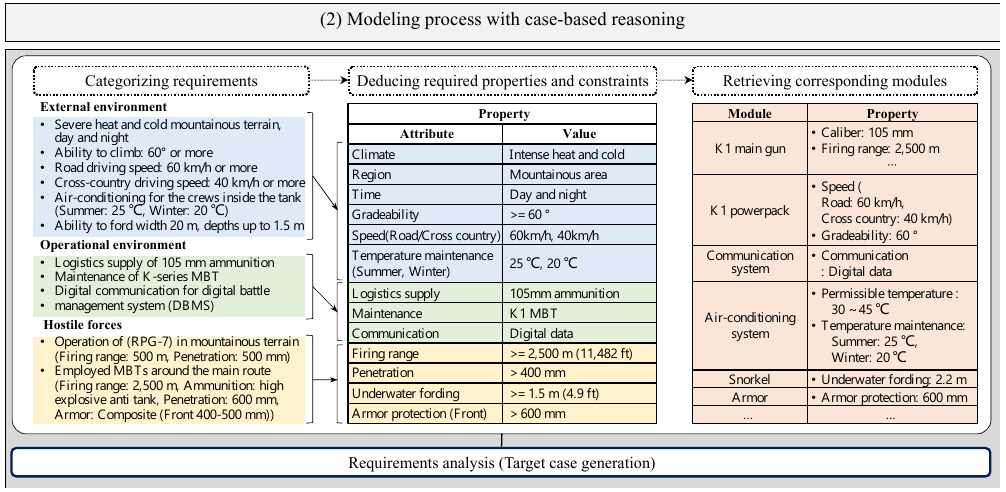
Figure 7. Flow of actions for the modeling process part (a).